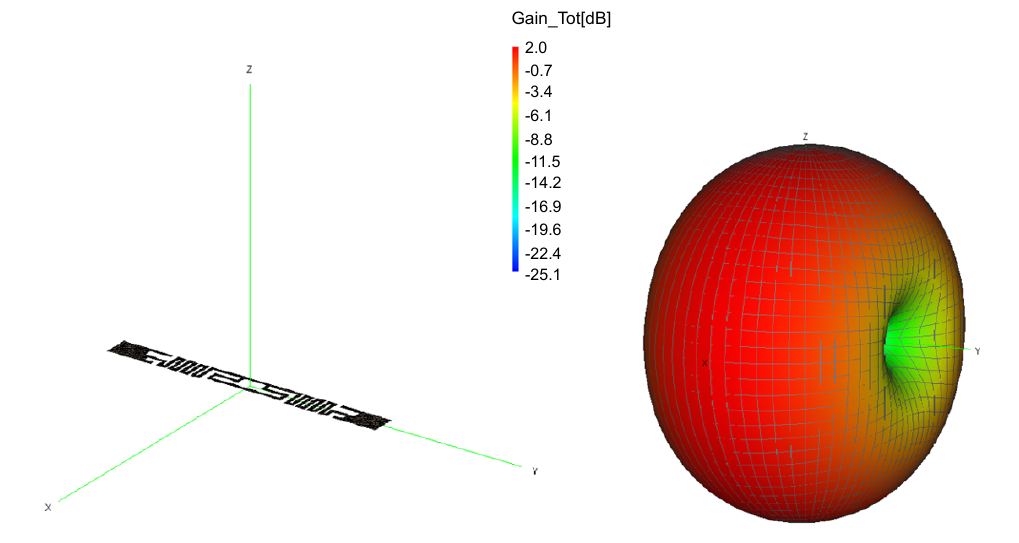
Figure 1. The tag structure and 3D radiation pattern at 920 MHz in free space. Table 1. Impedance and radiation efficiency results of tag antenna for different scenarios at 920